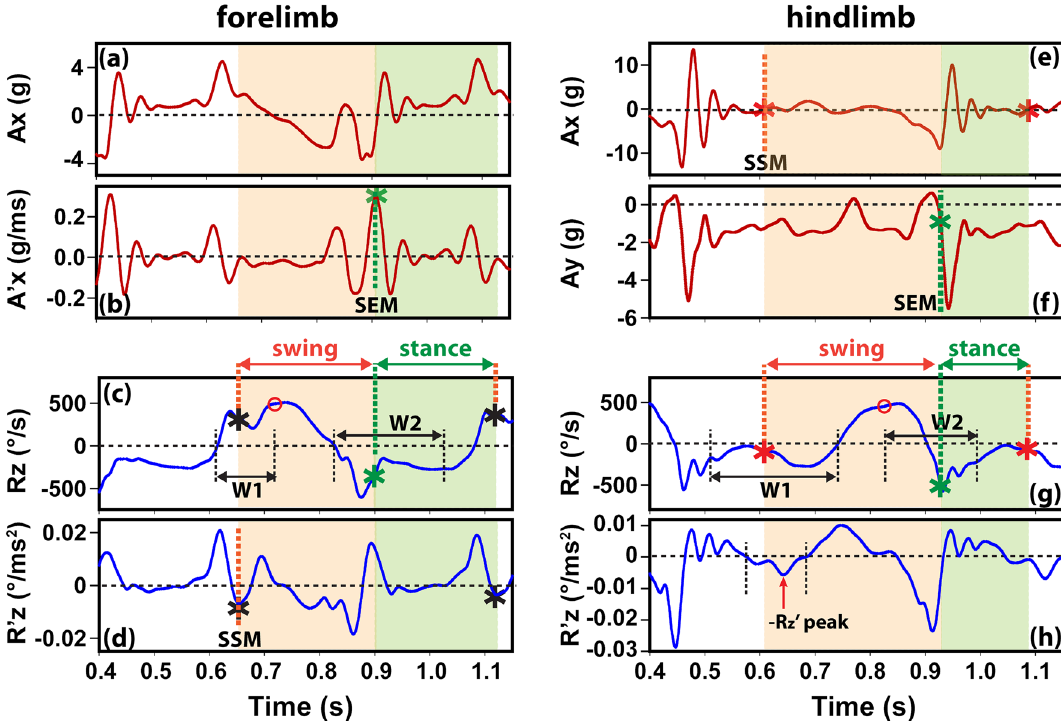
Figure 3. Examples of IMU signal markers (Table 1) used to detect the time points of swing start and end events in forelimb ( a – d ) and hindlimb ( e – h ). The black vertical dashed lines indicate the search window boundaries, whereas the star symbols indicate the location of the swing start marker (SSM, black/red star) and swing end marker (SEM, green star). W1 and W2 indicate the search windows for swing start and swing end,